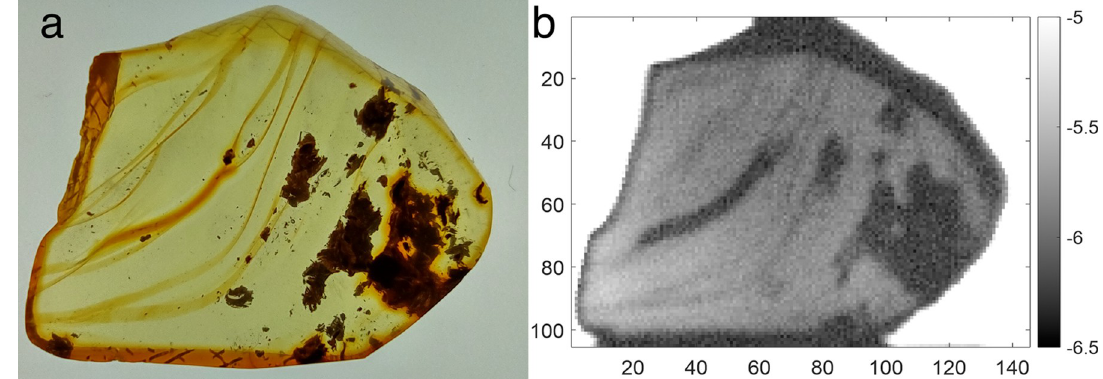
Fig 3. Imaging amber and inclusions. (a) Visible image of a sample of Baltic Amber with flow lines and inclusions. (b) Terahertz transmission image (1.5–2 THz) through the same sample on a natural logarithmic scale (scale value equals ln(T)). For the Terahertz image (29 by 21mm), the pixel resolution is 0.2 mm. For each pixel, twelve waveforms are averaged. The speed of imaging is 5 mm/s. The entire image took approximately 10 min to